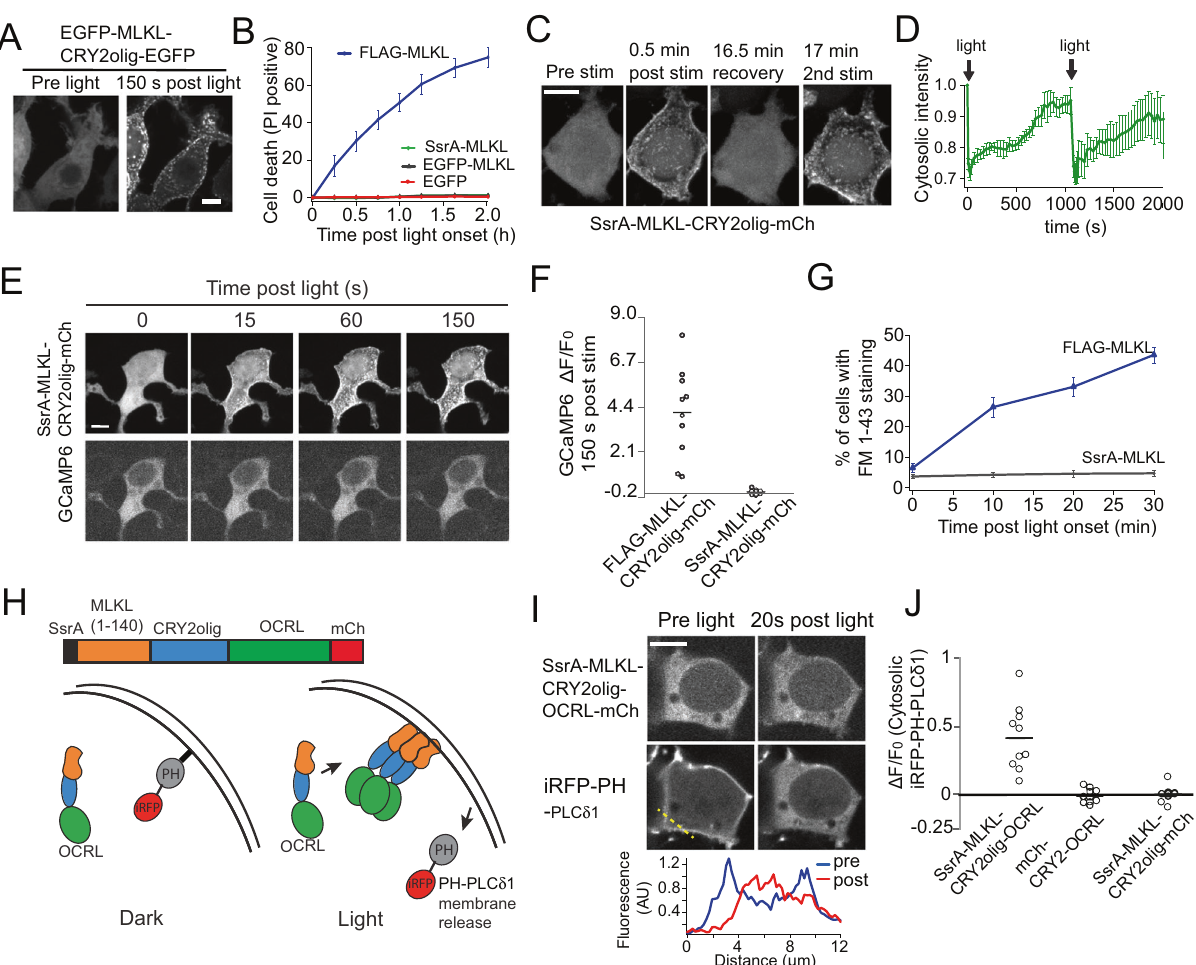
Fig. 6 Engineering a non-killing version of MLKL-CRY2olig that allows light-dependent recruitment to the plasma membrane. A Representative images of HEK293T cells expressing EGFP-MLKL-CRY2olig-EGFP before and 150 s after exposure to 488 nm light. MLKL is rapidly recruited to the PM. B Quanti fi cation of light-triggered death (PI staining) in cells expressing indicated MLKL-CRY2olig constructs. Fusion of EGFP or SsrA at the N-terminus of MLKL-CRY2olig-EGFP blocks triggered cell death. The graph depicts mean ± s.e.m., n = 3 independent experiments. C Representative images of cells expressing SsrA-MLKL-CRY2olig-mCh, before and after 488 nm light delivered at 0 and 16.5 min, with a 16.5 min period of recovery in between light stimulations. D Quanti fi cation of change in cytosolic levels of SsrA-MLKL- CRY2olig-mCh in the experiment as in ( C ). ( n = 6 cells quanti fi ed from two independent experiments, mean ± s.e.m.) E , F Representative images ( E ) and quanti fi cation ( F ) of cells expressing SsrA-MLKL-CRY2olig-mCh and GCaMP6 and exposed to light. No increase in GCaMP6 intensity is observed despite the recruitment of SsrA-MLKL to the plasma membrane. Cells expressing FLAG-MLKL, for comparison in ( F ), show a large increase in GCaMP6 signal. The graph shows n = 10 cells quanti fi ed from 2 independent experiments. G Percent of cells expressing FLAG-MLKL or SsrA-MLKL showing FM1-43 staining after light stimulation. Graph shows mean ± s.e.m. from three independent experiments. H Schematic showing strategy for recruiting SsrA-MLKL-CRY2olig-OCRL to PM with light. Recruitment results in the translocation of a PH- PLC δ 1 sensor from the PM to the cytosol. I Representative images of cells expressing SsrA-MLKL-CRY2olig-OCRL-mCh and iRFP-PH-PLC δ 1 before and after light induction. The graph below shows the relative fl uorescence intensity of iRFP-PH-PLC δ 1 at the dotted white line before and after blue light. J Quanti fi cation of fold change in cytosolic iRFP-PH-PLC δ 1 intensity [(Intensity post − Intensity pre )/Intensity pre ] 20 s after light induction in cells expressing indicated OCRL fusions and control constructs. All scale bars, 10